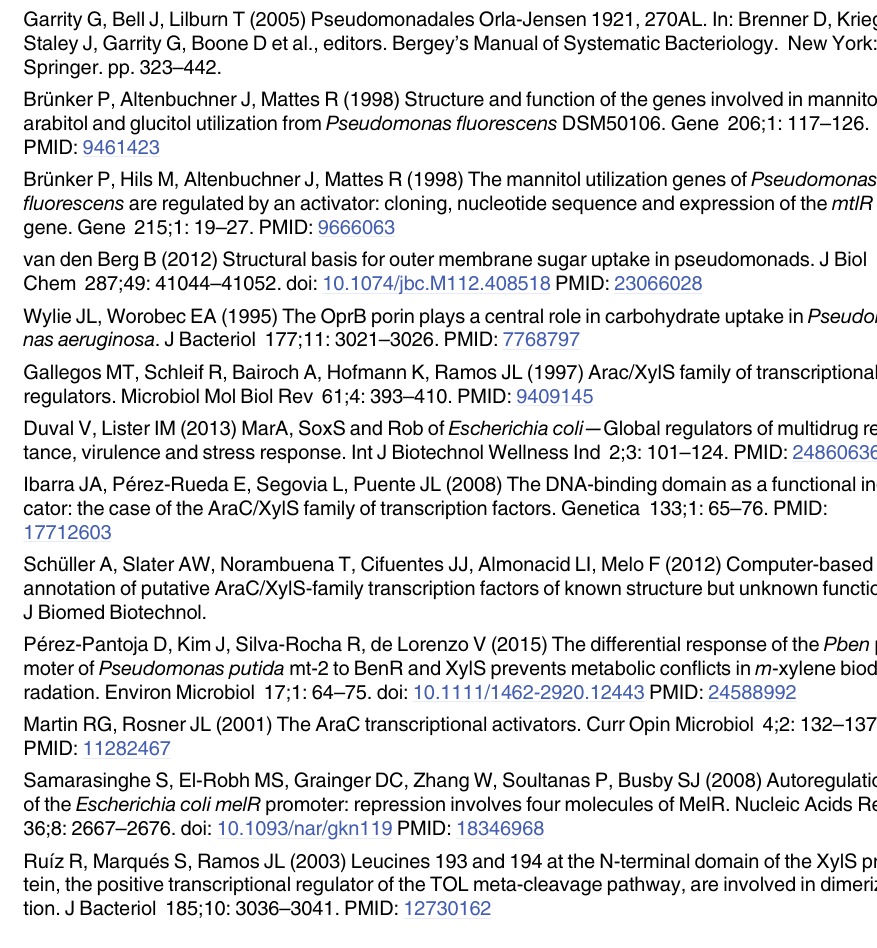
(PDF) S1 Table. Oligonucleotides used in this study. S2 Table. PCRs used for EMSA and DNaseI Footprinting